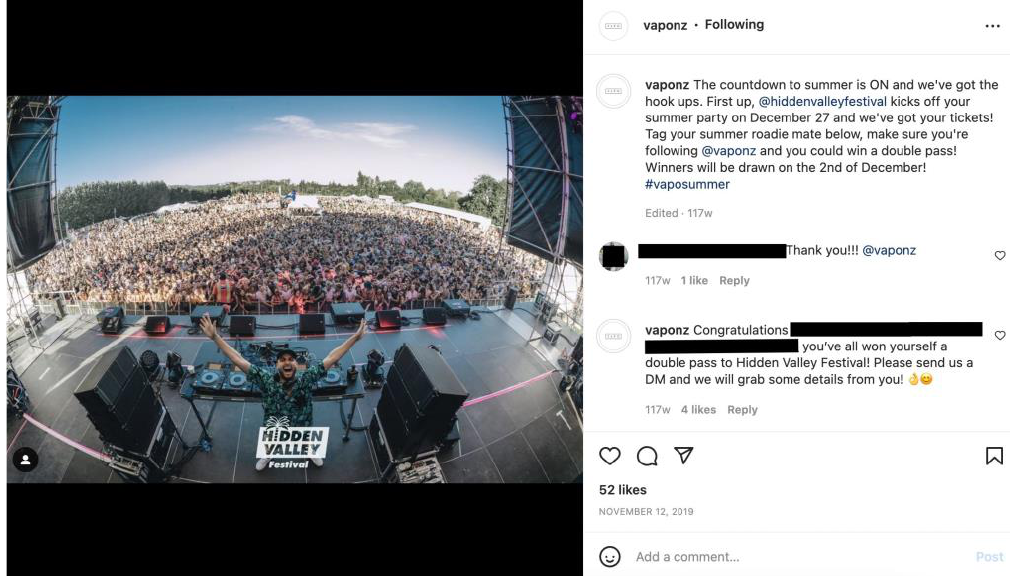
Figure 3. Example of an Instagram post promoting a music event.